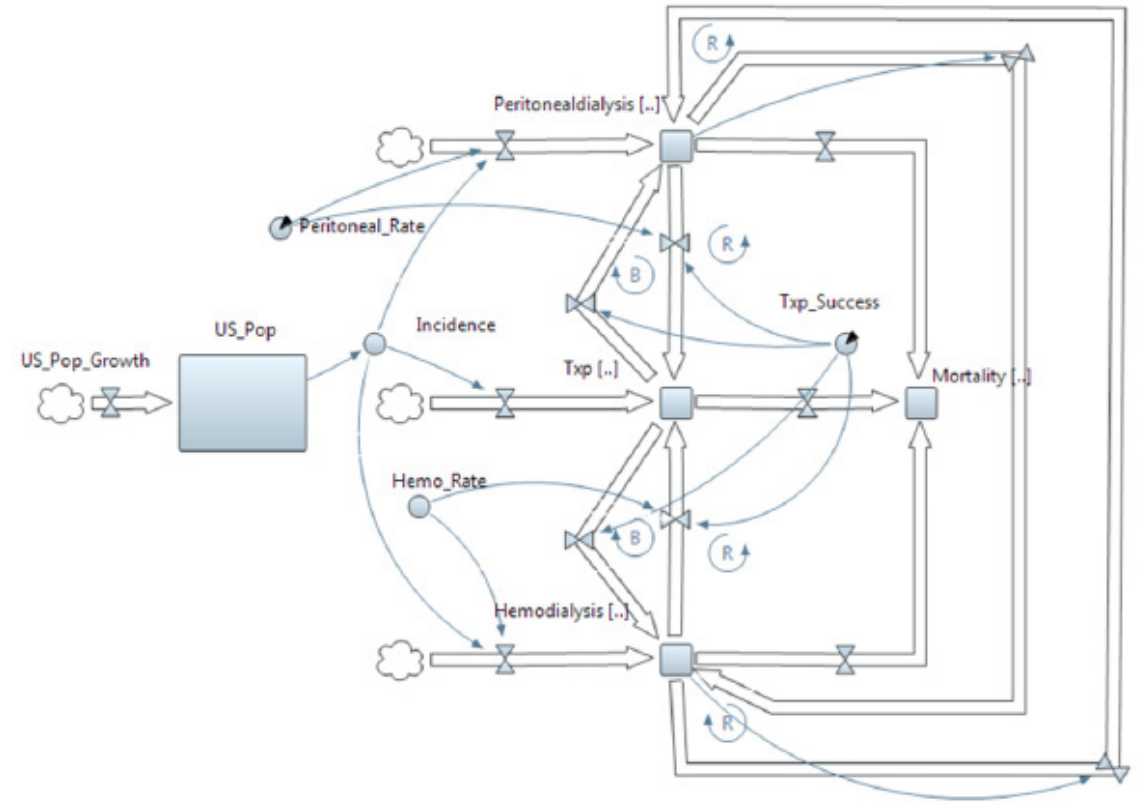
Figure 1. Example of Dialysis Critical Care Pathway